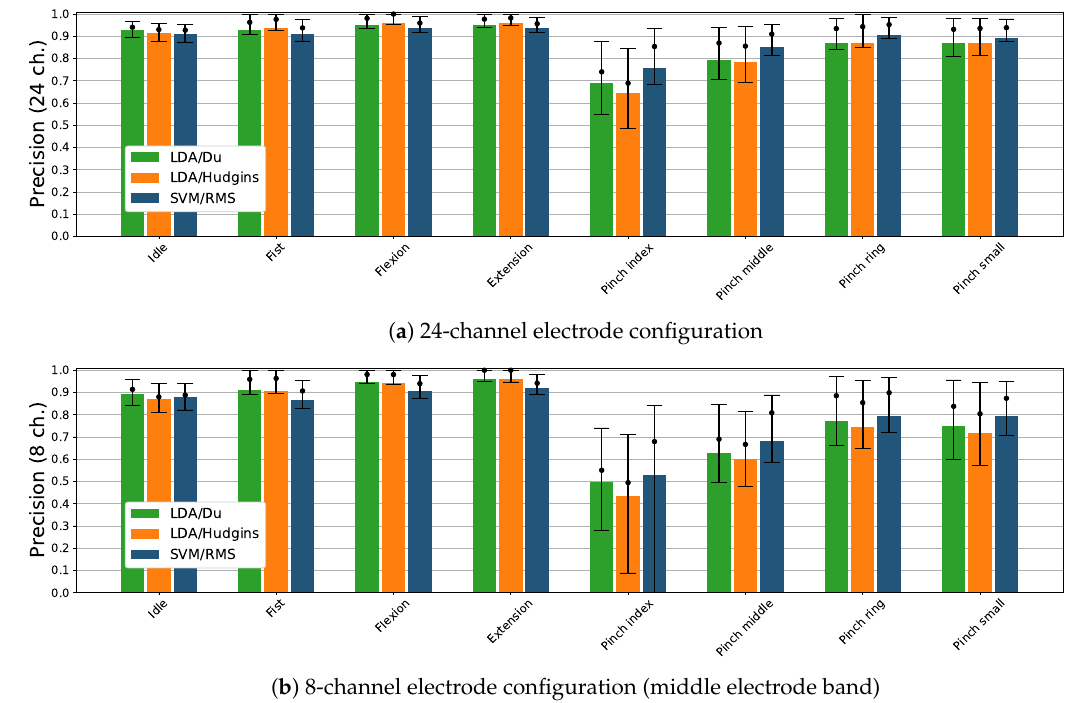
Figure 8. Classification precision for selected classifiers and feature sets combinations, presented for each active gesture in the putEMG dataset; bars represent mean value; dots mark precision median value together with 25th and 75th